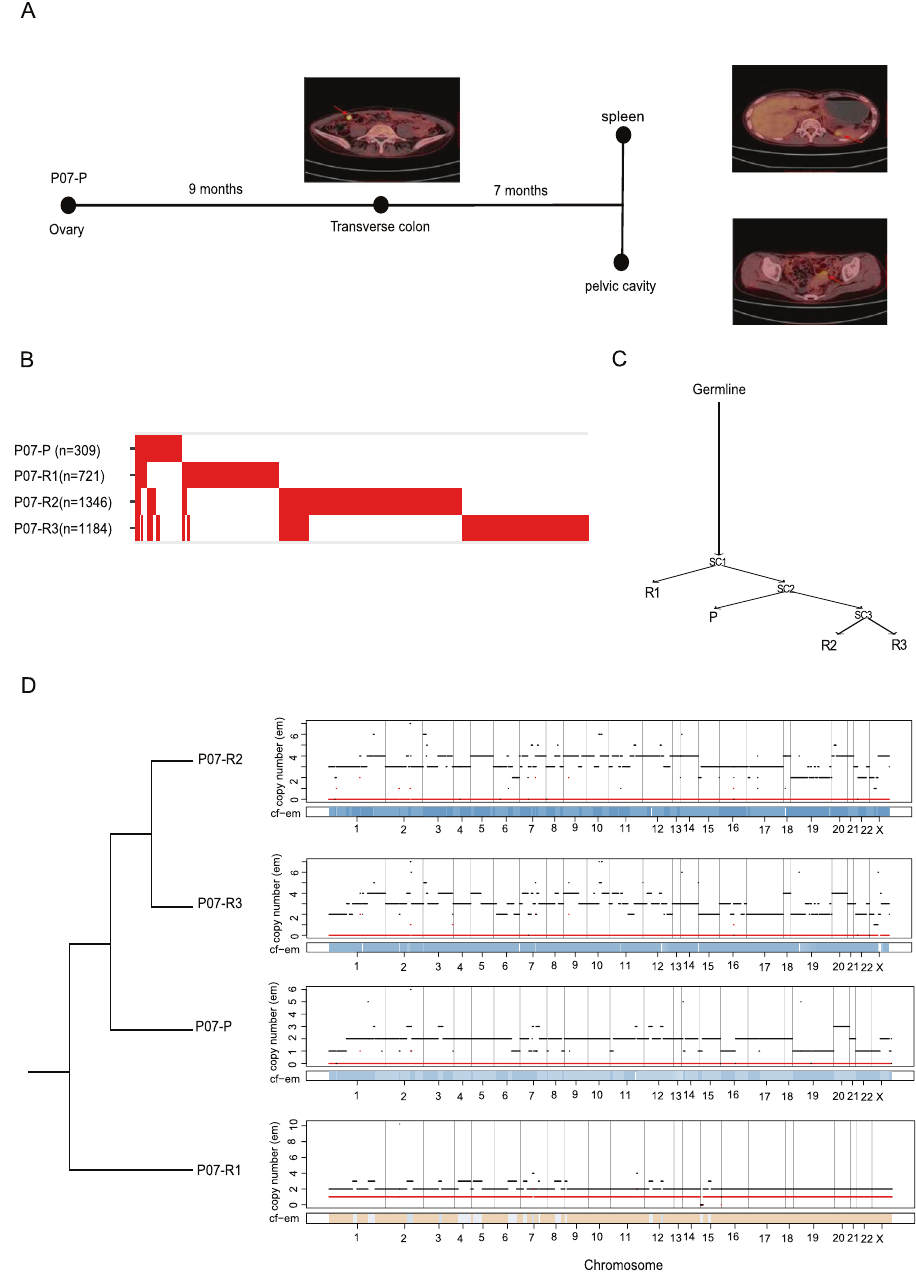
Fig. 5 Evolution of YST progression from a single patient. A The PET-CT tomography of patient P07 at different diagnostic time points. B The alignment of all mutations in the primary and three relapse tumor samples from P07. The mutation numbers included in the analysis are shown in parentheses. C A phylogenetic tree showing evolutionary relationships between the tumor samples. Selected mutations are shown along the lineages. D A phylogenetic tree among the four tumor samples from P07 based on their LOH